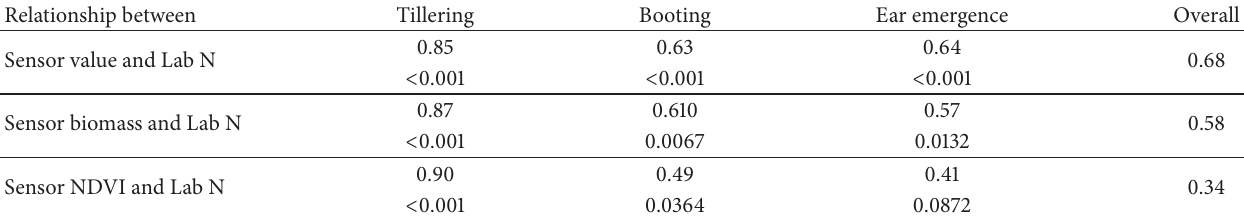
0.68 0.58 0.34 0.63 0.65 0.58